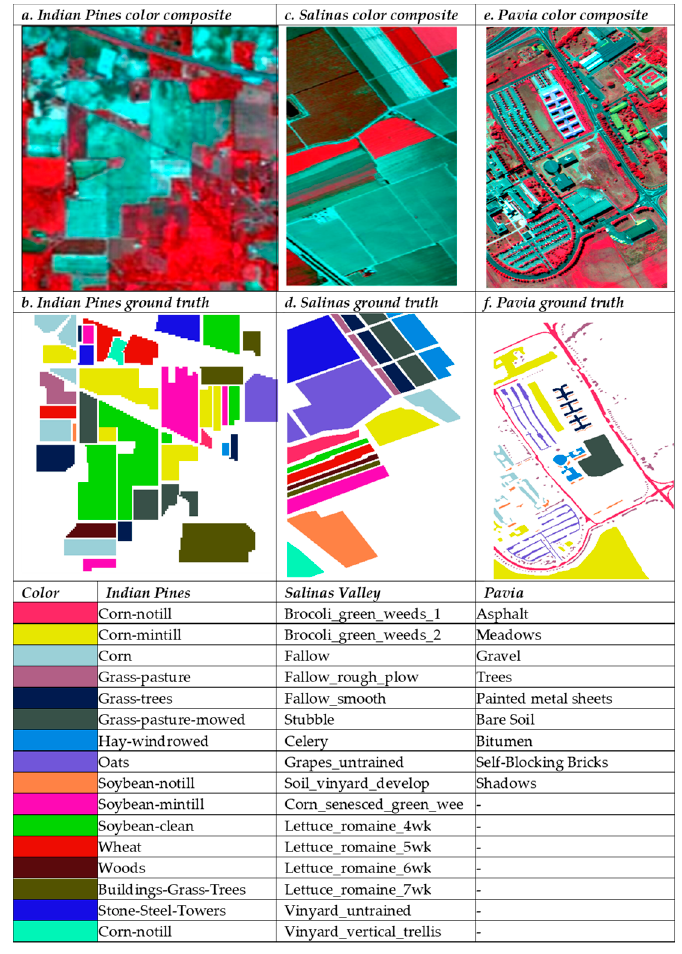
Figure 3. False color composites and ground truth images of the datasets used to illustrate the image classification using DoTRules, including the ( a , b ) Indian Pines, ( c , d ) Salinas and ( e , f ) Pavia University datasets.